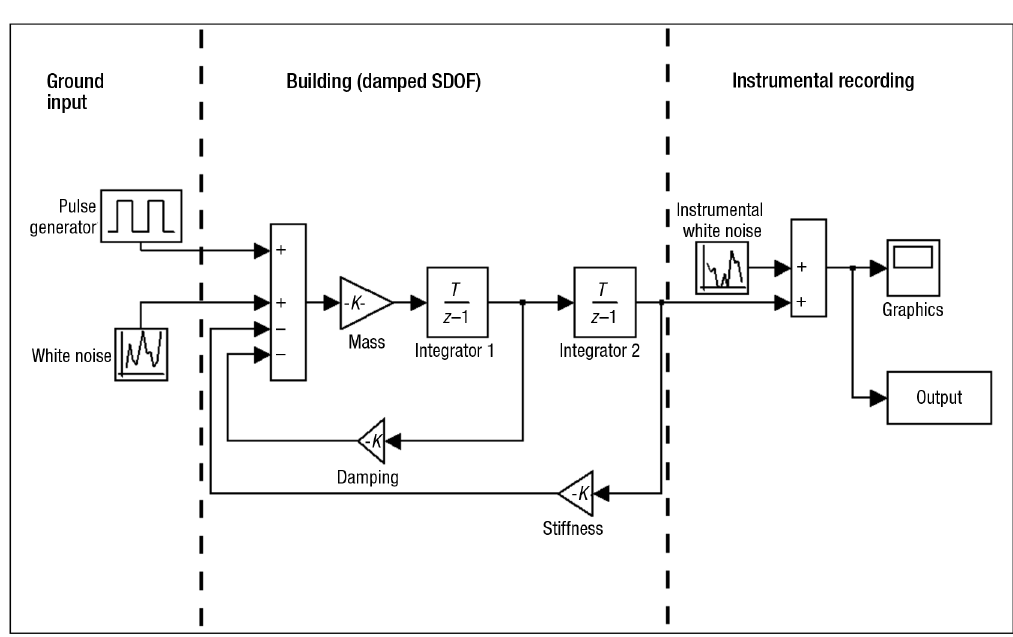
Fig. 1. SimuLink block model implemented to verify the assumptions underlying the NonPaDAn